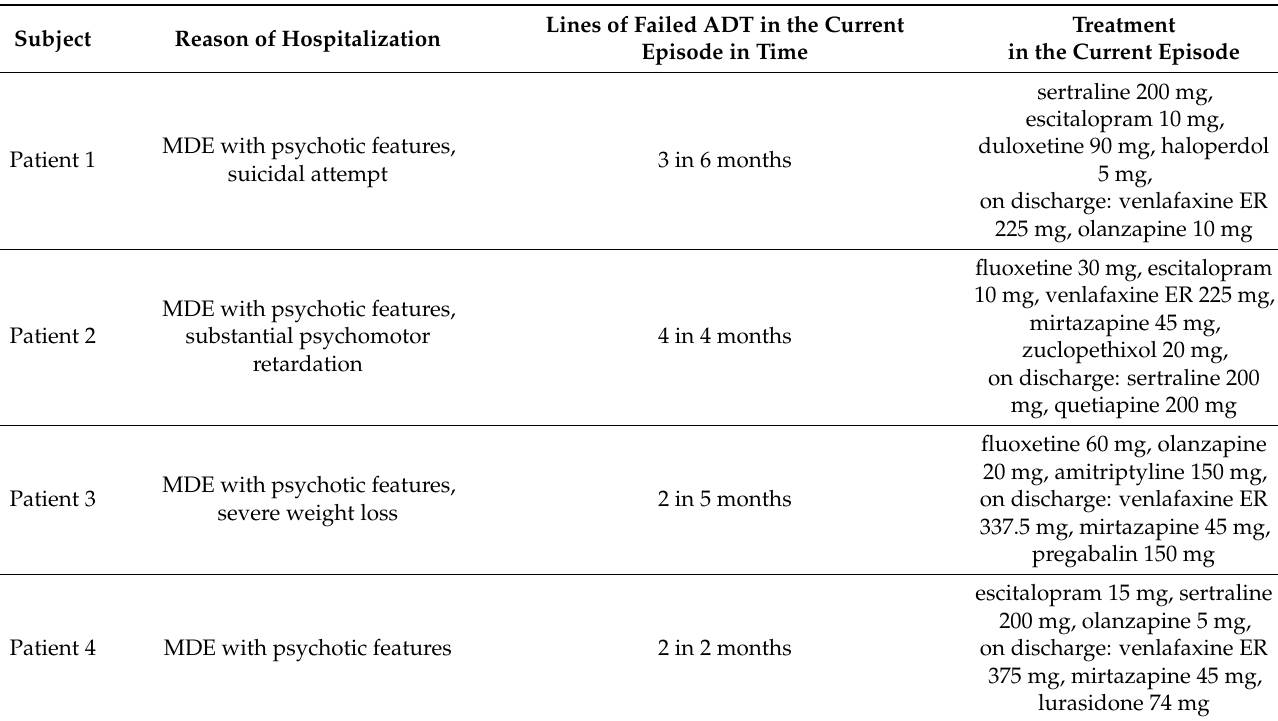
Table 2. Current MDD hospitalization